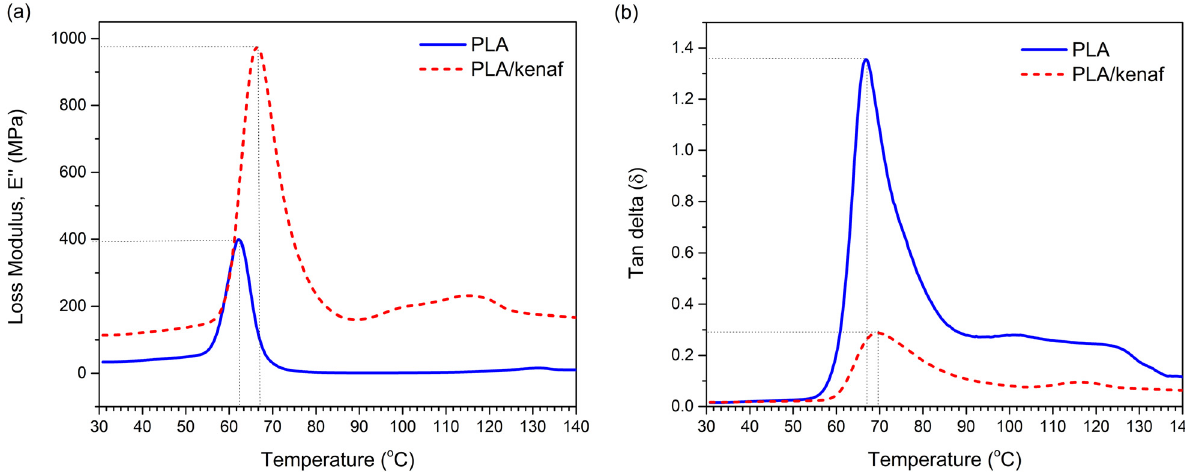
Figure 5: ( a ) Loss modulus and ( b ) loss factor ( tan δ ) of pure PLA and the UD PLA – kenaf composite with a 0° fi ber